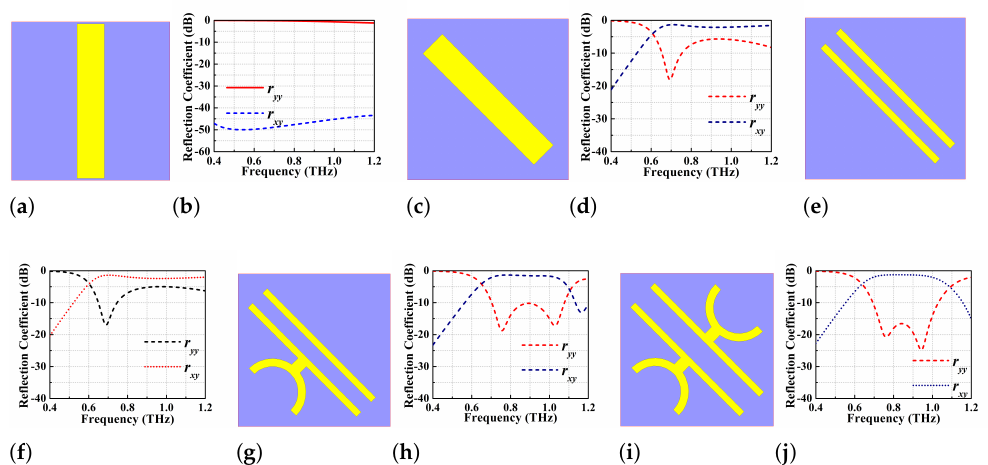
Figure 2. Proposed polarisation converter design steps with corresponding co-pol ( r yy ) and cross − pol ( r xy ) reflection coefficients ( a , b ) rectangular gold patch along the x-axis, ( c , d ) 45 ◦ rotated rectangular patch w.r.t x-axis, ( e , f ) rectangular slot of width 10.5 µ m employed to 45 ◦ rotated gold patch, ( g , h )